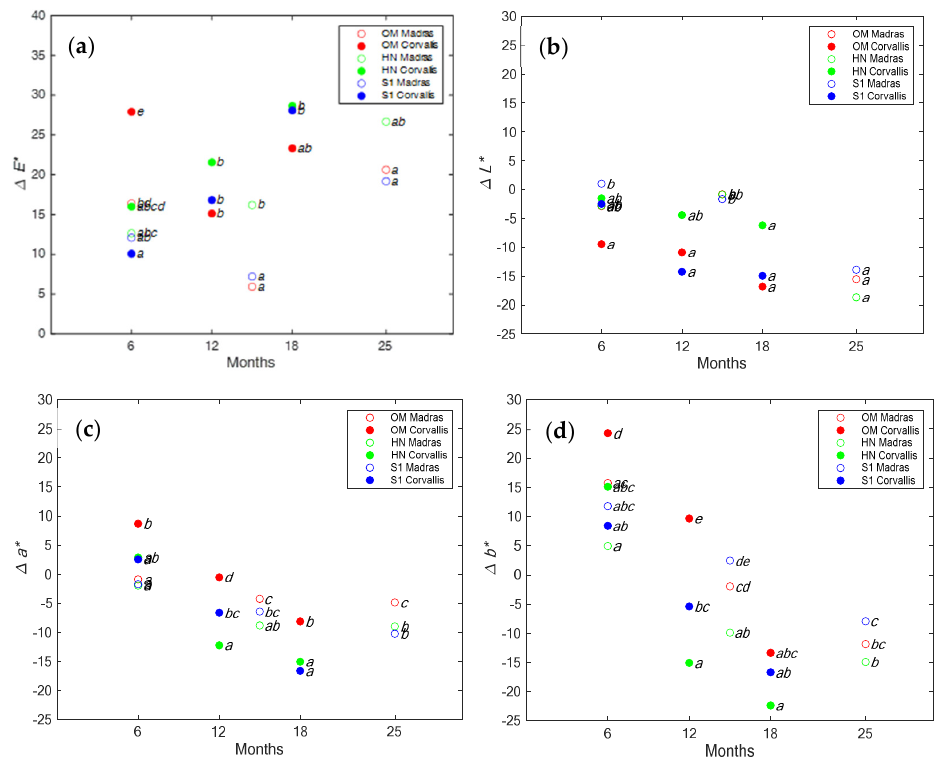
Figure 5. Games–Howell pairwise mean differences in ∆ E , ∆ L* , ∆ a*, and ∆ b* for each species/coating combination from each location for Douglas fir. Values with the same letter indicate that means between intervals do not differ significantly at p < 0.05. ( a ) color change ( ∆ E) , ( b ) ∆ L* , ( c ) ∆ a* , ( d ) ∆ b* .